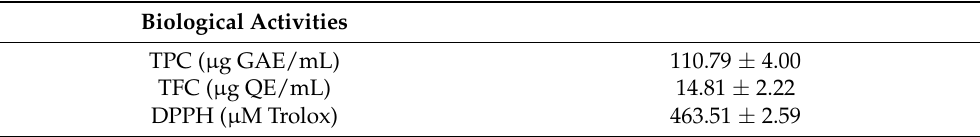
Table 5. Total phenolic content, total flavonoids content, and antioxidant activity by DPPH method of ASTRA root